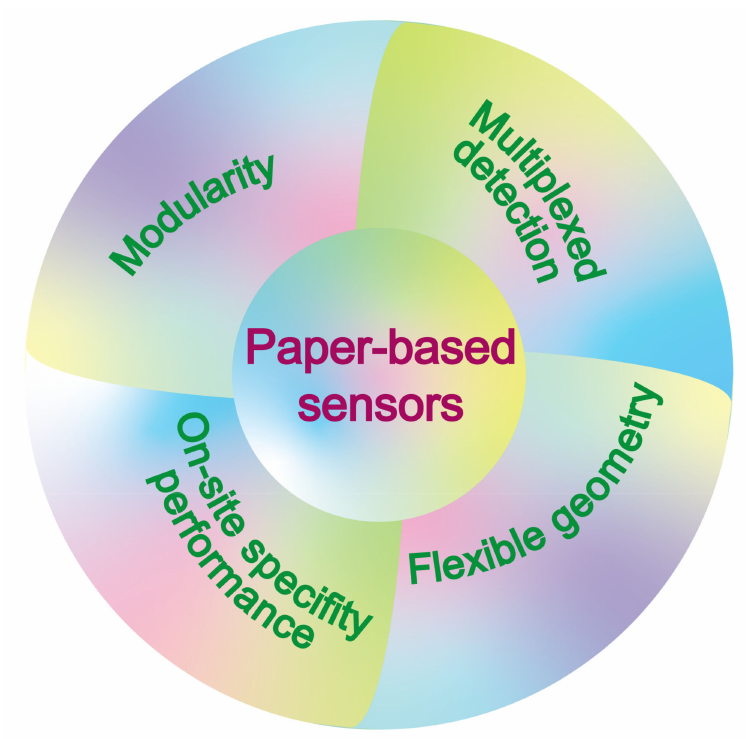
Figure 6. Developing directions for paper-based sensors with more practicality and promo- tional